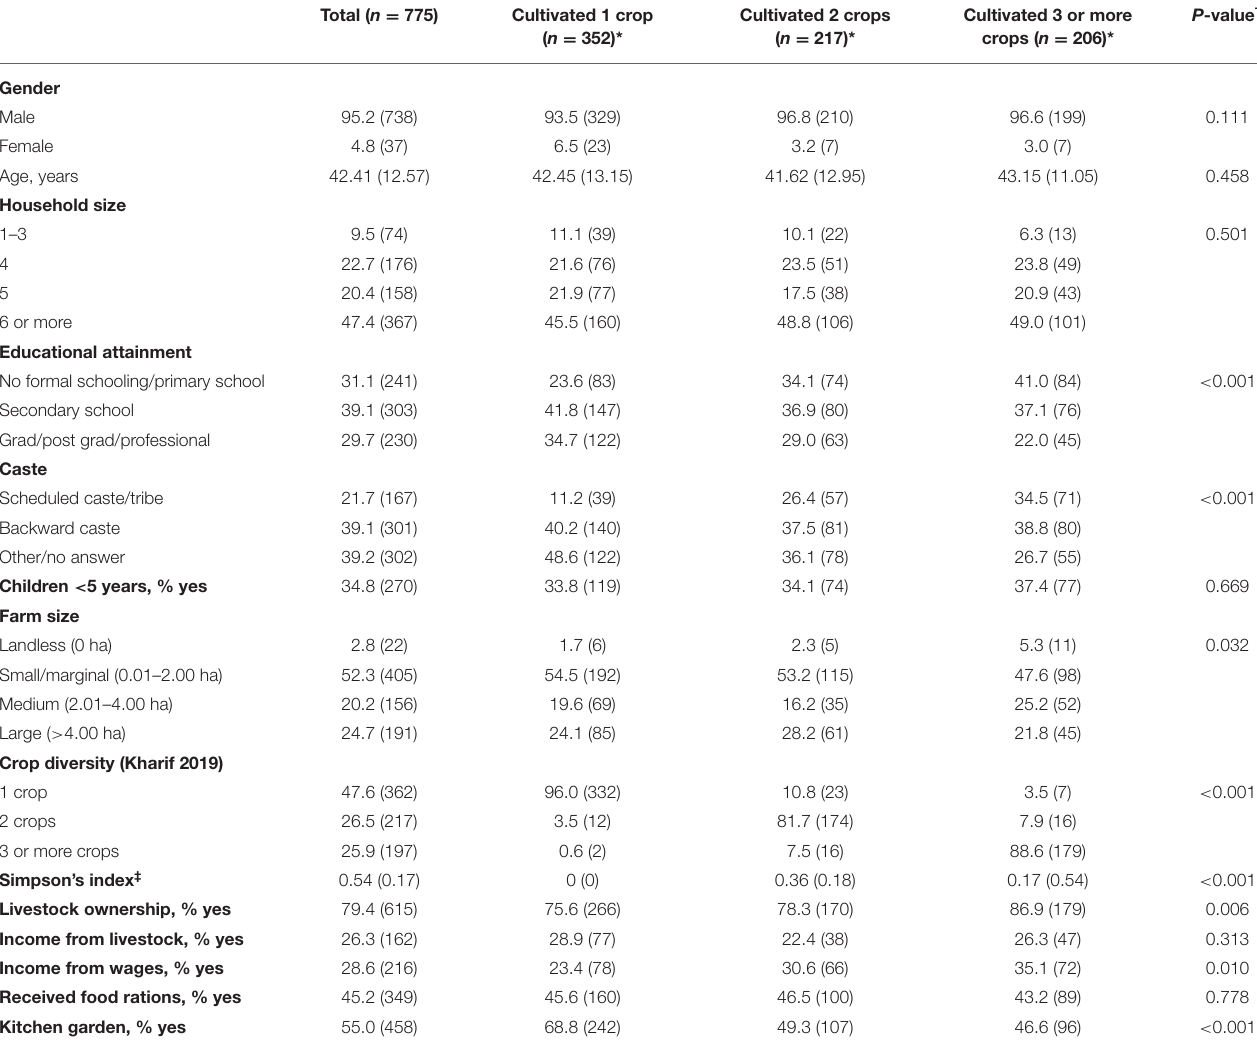
TABLE 2 | Demographic characteristics of participants from agricultural households across 12 states in India during the COVID-19 pandemic, according to number of crops cultivated in Kharif 2020 ( n = 775).